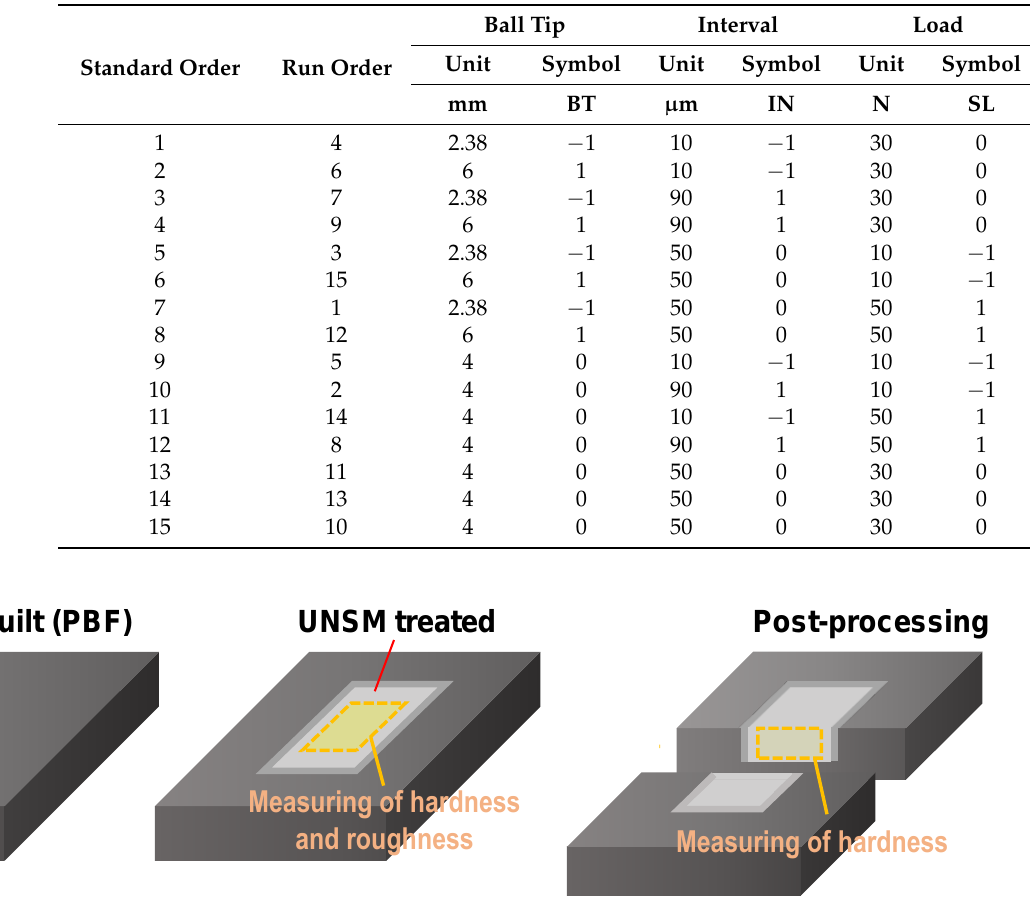
Table 3. Design of experiment with three parameters.